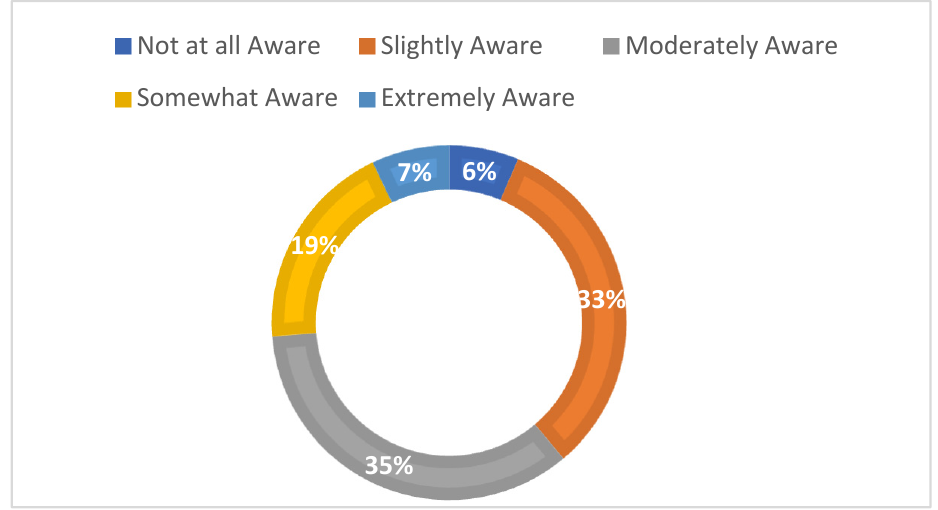
Figure 3. Awareness level of BIM technology in high-rise buildings.